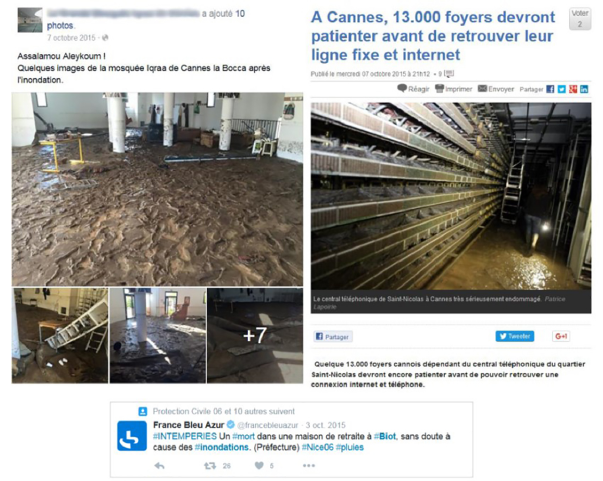
Figure 2. Examples of flood-related damage information publicly available in new media (from left to right and below: screenshot of the Facebook page of a mosque in Cannes, screenshot from the Nice-Matin newspaper website, and a screenshot of a tweet from the France Bleu Azur radio).